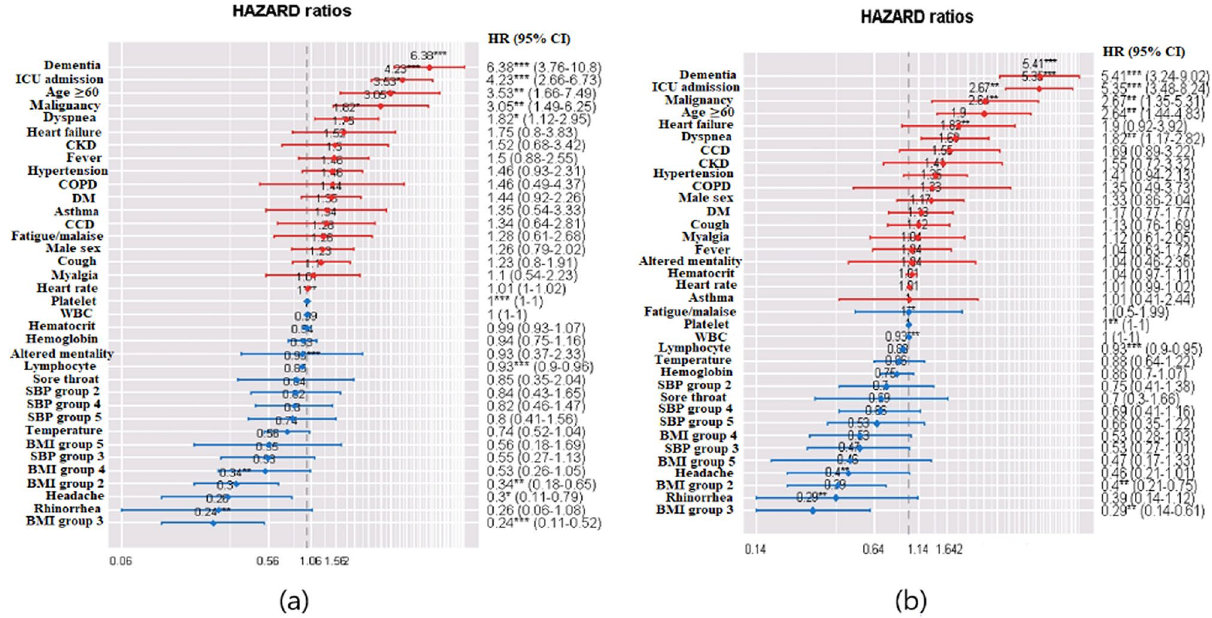
Figure 3. Hazards ratio plot in prediction of mortality ( a ) and fatal adverse outcomes ( b